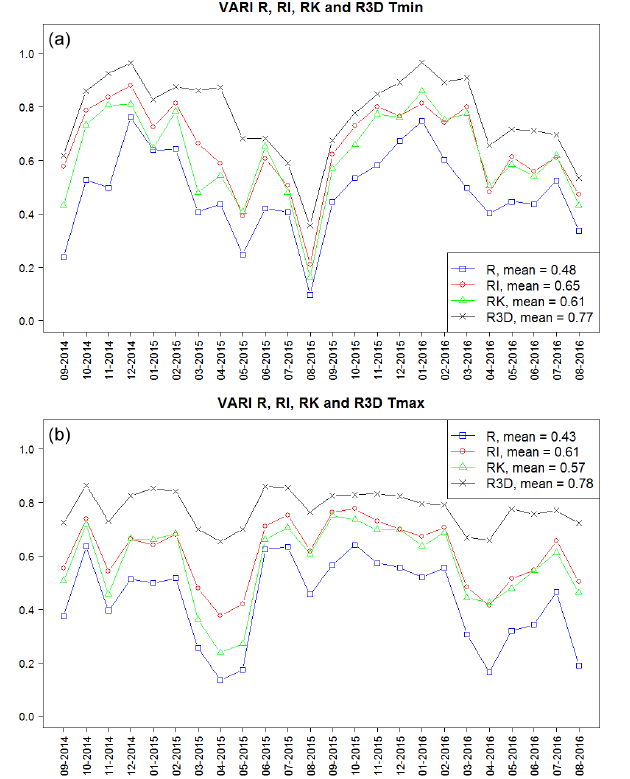
Figure 2. Results of the RMSE calculation for all interpolation models, where R = Regression, RI = Regression + two dimensional IDW, RK = Regression + Kriging, R3D = Regression + three di- mensional IDW, for minimum temperature (a) and maximum tem- perature (b) .